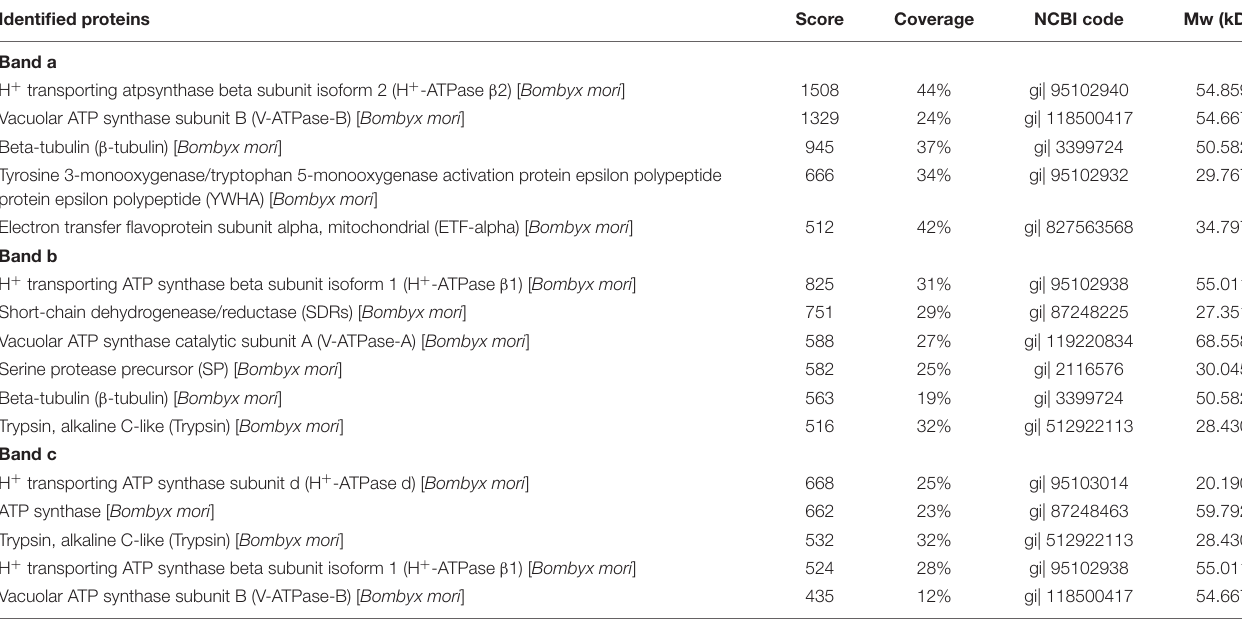
FIGURE 2 | Identification of virus-binding of the mitochondrial proteins fraction of the P50 midgut on SDS-PAGE. (A) Separation of Bombyx mori midgut mitochondrial (MC) and BmNPV budded viruses (BVs) proteins by SDS-PAGE. (B) Virus overlay binding experiment. Mitochondrial protein blots, overlaid with (MC + BV) and without BVs (MC-BV) were incubated with antibodies against the AcMNPV gp64 protein to detect the BVs. BmNPV Budded virus was used as a positive control (BV) to gp64 protein. Arrows a, b, and c in (A,B) refer to the bands detected in the stained gel and the PVDF membrane. M, protein molecular weight marker. TABLE 1 | Identification of BmNPV-binding proteins in B. mori midgut mitochondria separated by SDS-PAGE and identified by LC-MS/MS. Identified